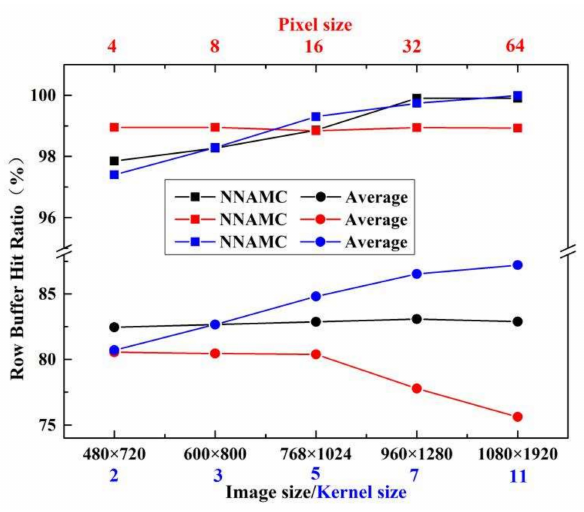
Figure 13. Comparison of row buffer hit ratios of NNAMC with different network